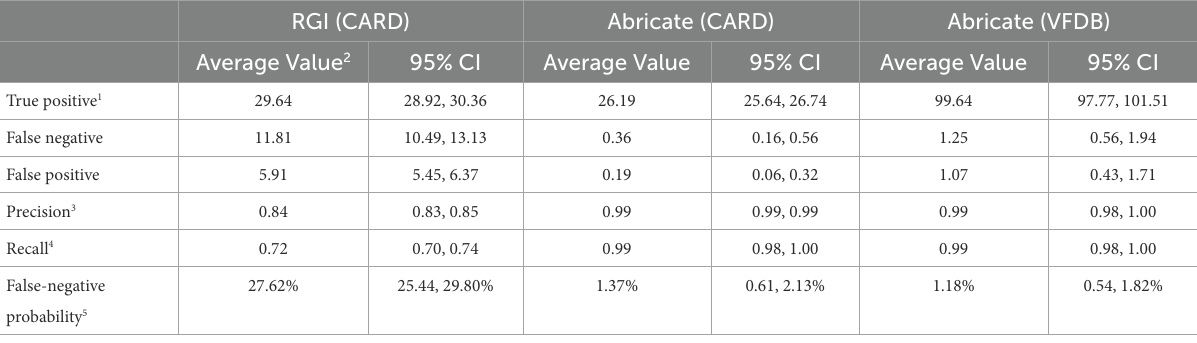
TABLE 6 Accuracy of AMR/virulence gene identification using ONT multiplex sequencing data.